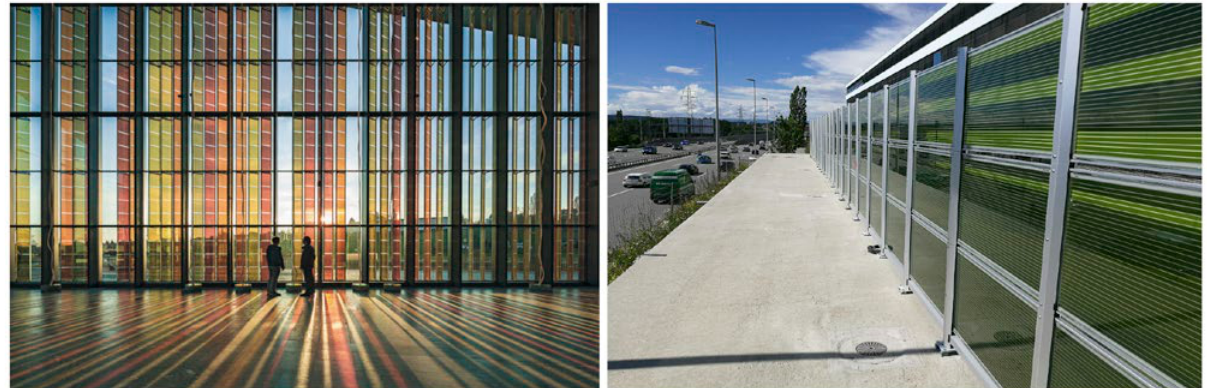
Figure 6. Examples for DSSC-based photovoltaic glazing. Left: DSSC panels produced by the company Solaronix (www.solaronix.ch) mounted at the façade of the Swiss High-Tech Convention Centre in Lausanne, Switzerland. Right: The first energy-producing noise-barrier based on the DSSC panels developed by the Swiss company H.Glass is installed on the highway between Bern and Zurich in